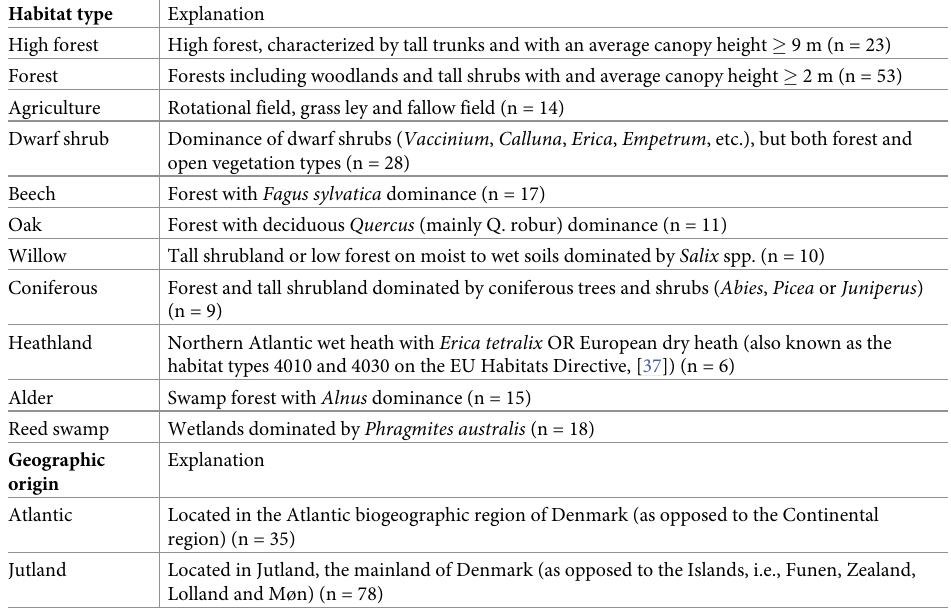
Table 1. Habitat types and geographic origins and their description. Habitat